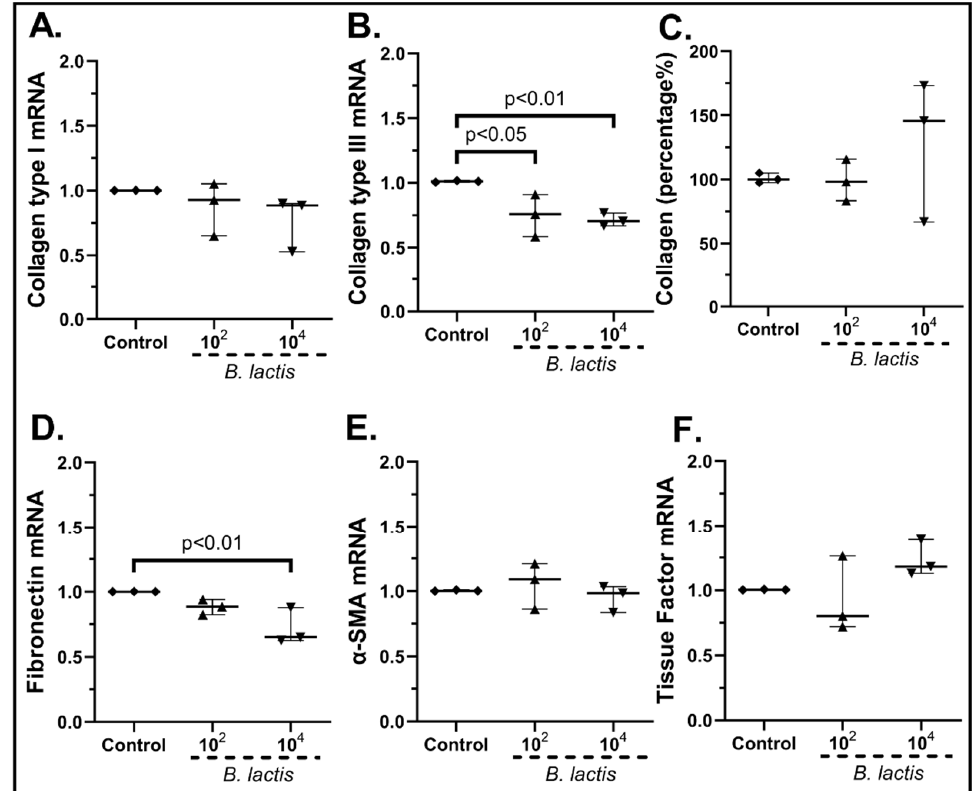
Figure 10. cSEMF mRNA expression of Collagen Type I ( A ), Collagen Type III ( B ), Fibronectin ( D ), α-SMA ( E ), Tissue factor ( F ) and Collagen secretion ( C ) after stimulation with Bifidobacterium lactis. Results are presented as median with interquartile range. N = 3.